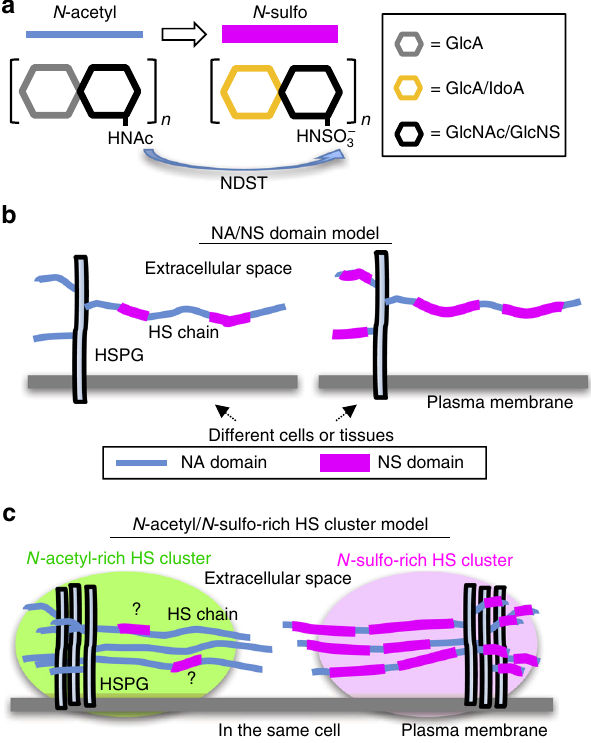
Fig. 1 Models for heparan sulfate chain structures/organizations. a NDST ( N- deacetylase/ N- sulfotransferase). The fi rst modi fi cation step of the heparan sulfate (HS) precursor chain is the conversion of N- acetyl moiety (NA) to N- sulfo moiety (NS), which is catalyzed by NDST. b The NA/NS domain model of a single HS chain. A single chain of HS generally contains two types of domains, N- acetyl (NA) and N- sulfo (NS). c Our model of distinct N- acetyl-rich HS and N- sulfo-rich HS clusters. See the main text for